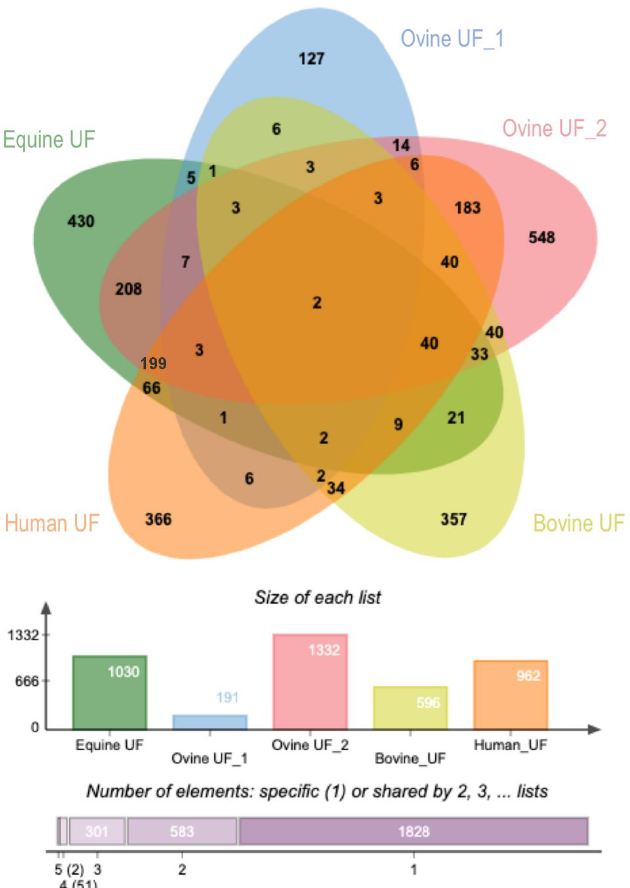
Figure 10. Comparative analysis of uterine EVs protein cargo among species. Venn diagram showing the overlap of proteins identified in uterine EVs from uterine flushings collected in different species and studies using different EVs isolation methods (number of total proteins). Table 1. Overlap of percentage of identified proteins in uterine EVs among studies in different or the same species and using different or similar EVs isolation method. UF: uterine fluid; CE: Centricon ultrafiltration device; IZON: size exclusion chromatography; UC: